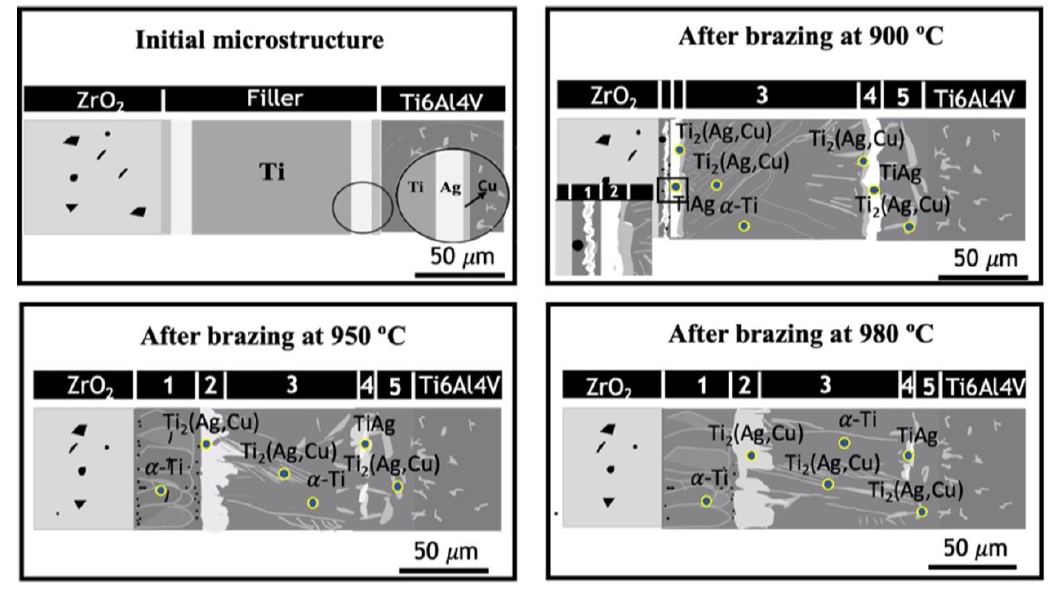
Figure 6. Schematic representation of the evolution of the interfacial microstructure.